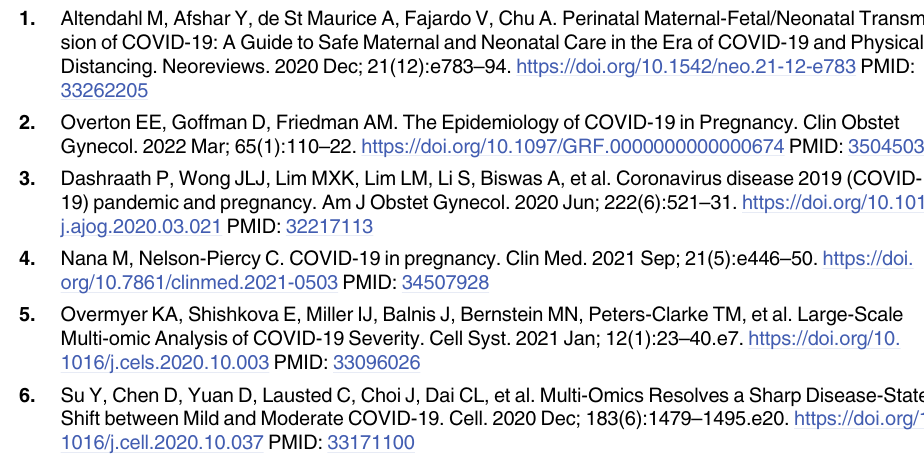
S2 Table. Pathway enrichment. S1 Fig. Quality